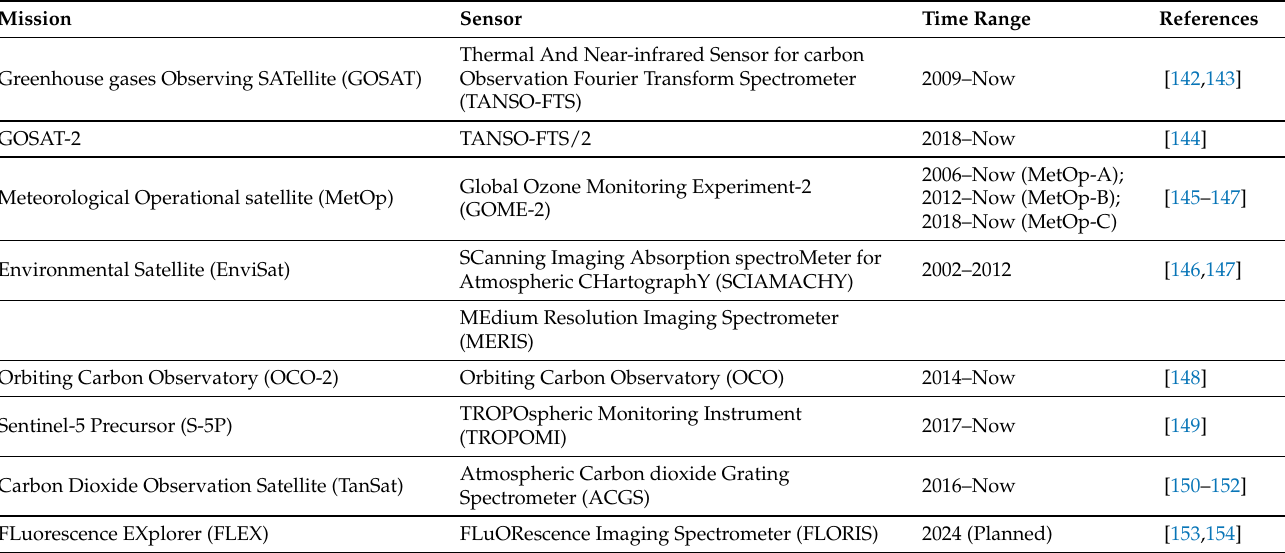
Table 2. Summary of satellite missions capable of solar-induced chlorophyll fluorescence measurements. Mission Sensor Time